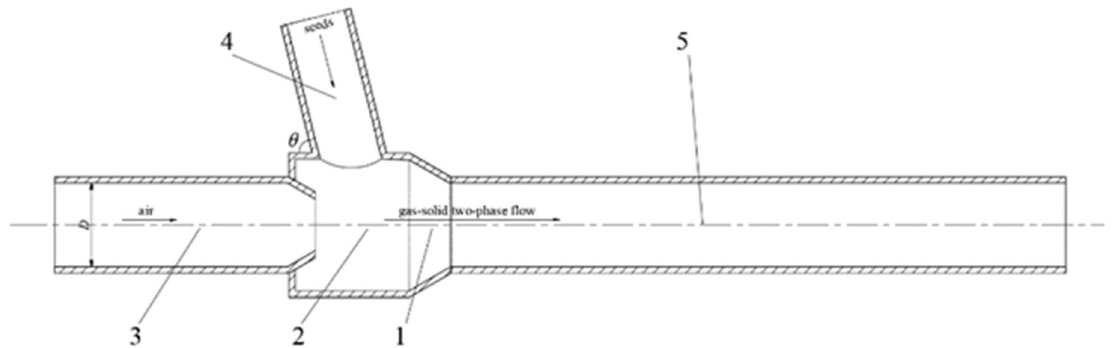
Figure 2. Schematic diagram of the structure of the venturi tube. (1. Transition area; 2. Mixing area; 3. Air inlet area; 4. Seed-feeding area; 5. Conveying area).